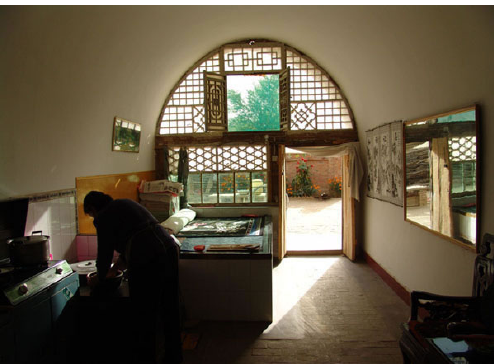
Figure 14. Indoor image